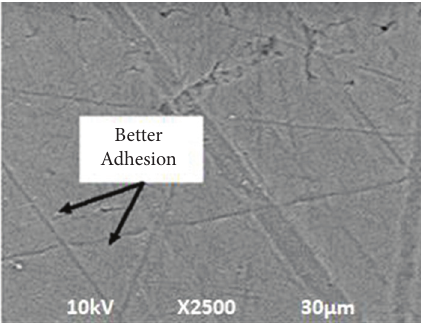
Figure 14: SEM micrograph of worn alkali-treated polypropylene-graft-maleic anhydride (T+ PP+MAPP) sample at different loading conditions.